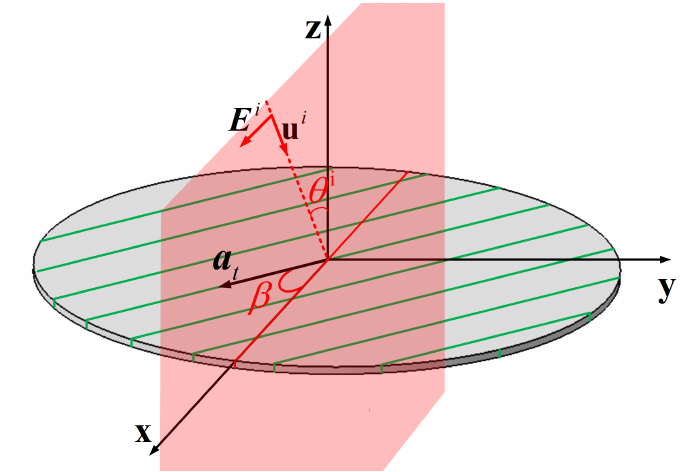
Figure 1. A Soft-and-Hard/DB (SHDB) disk with a diameter of 3 λ and a thickness of 0.04 λ . The green lines indicate the direction of the vector a t on the surface of the disk. Vectors u i and E i show the directions of the incident wave and the incident electric